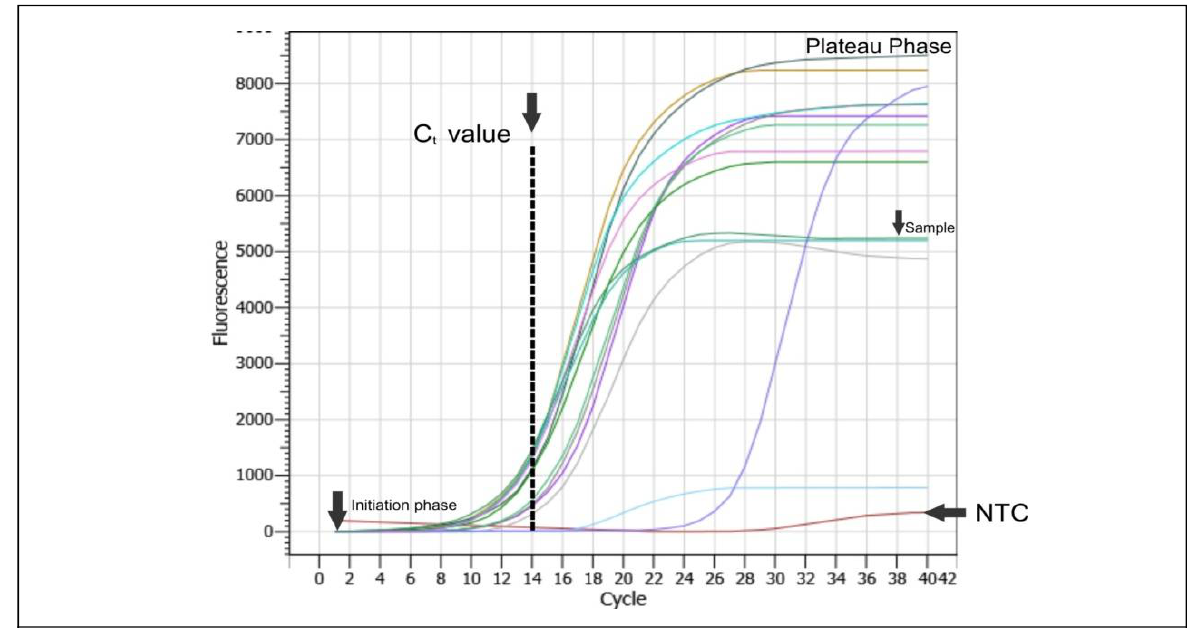
Figure 1: Amplification curves for LmcesA20. This graph shows the fluorescence increase for different samples with the number of cycles. The threshold was set above the limit of detection, but well below the stage where the amplification rate slows down Note: NTC means Null Template Control